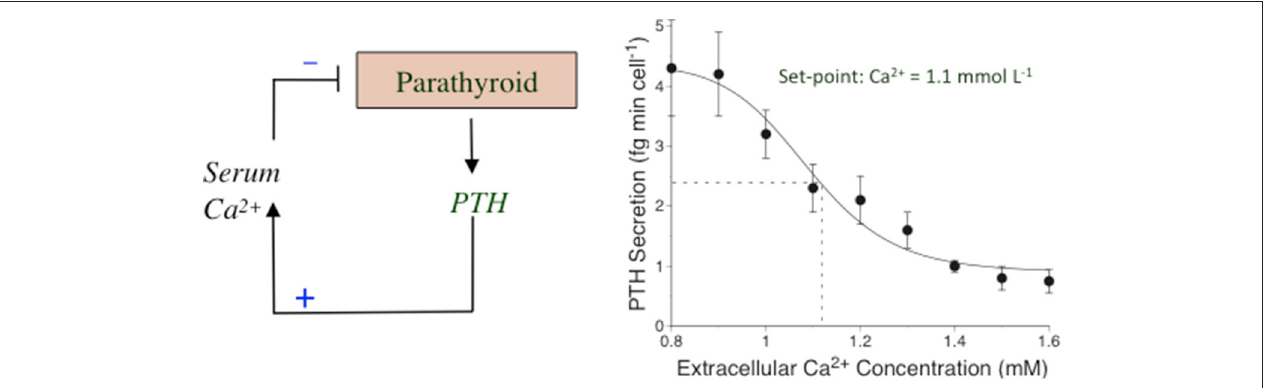
FIGURE 1 | The calciostat in parathyroid cells. Left: A representation of the feedback mechanism by which PTH elevates the serum* Ca 2 + concentration and Ca 2 + feeds back on the parathyroid to suppress PTH secretion in a process mediated by the CaSR. Right: Human parathyroid cells were perifused with HEPES-buffered physiological saline solutions containing various Ca 2 + concentrations and samples of perifusate were collected at various times and subsequently analyzed for PTH1–84 as described in Conigrave et al. (2004). The results have been re-drawn. *Total and ionized calcium concentrations are comparable in serum and plasma since the major calcium-binding protein, albumin is present in similar concentrations in both these